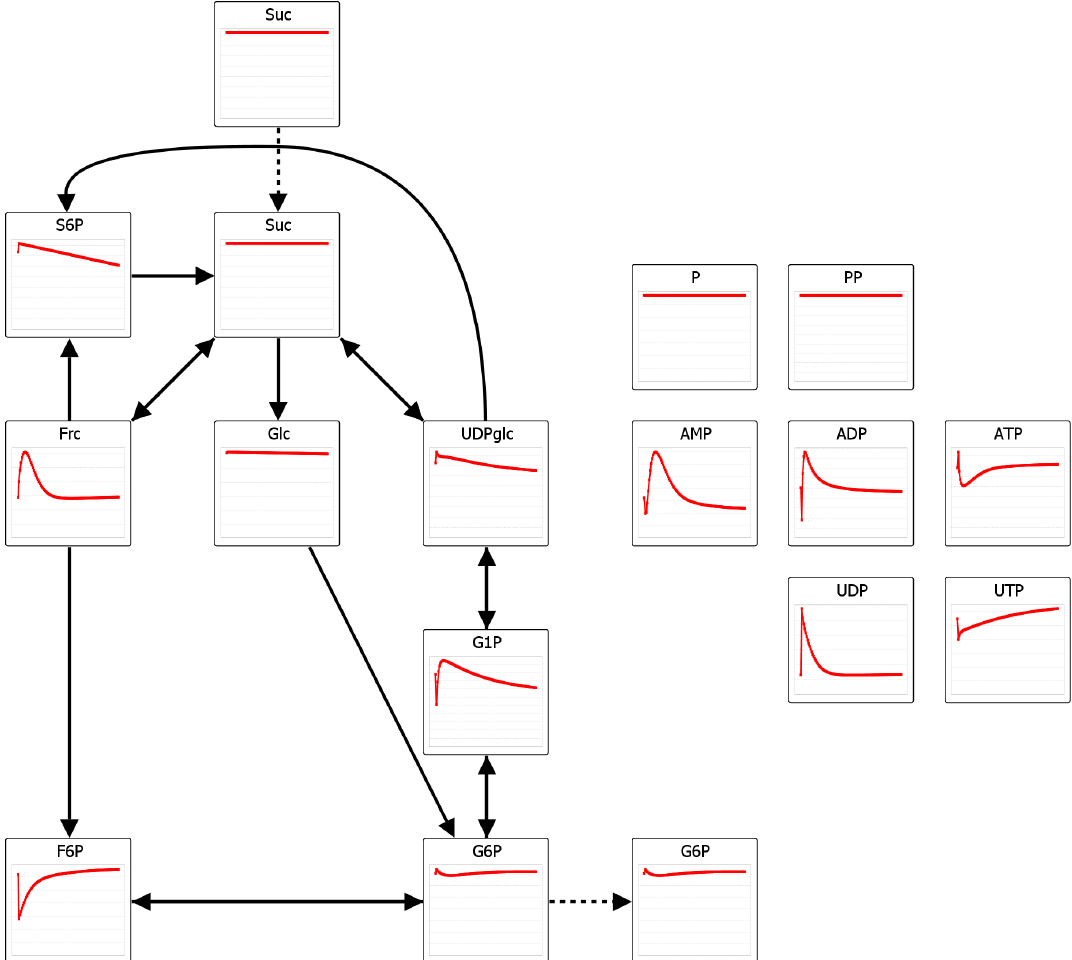
Figure 6: Simulation results of Gepasi for the pathway shown in Fig. 5, visualised in V ANTED . Suc, PP and P concentrations were fixed. Abbreviations: ADP, adenosine diphosphate; AMP, adenosine monophosphate; ATP, adenosine triphosphate; Frc, fructose; F6P, fructose 6-phosphate; Glc, glu- cose; G1P, glucose 1-phosphate; G6P, glucose 6-phosphate; P, phosphate; PP, pyrophosphate; Suc, sucrose; S6P, sucrose 6-phosphate; UDPglc, uridine diphosphate glucose; UDP, uridine diphos- phate; UTP, uridine